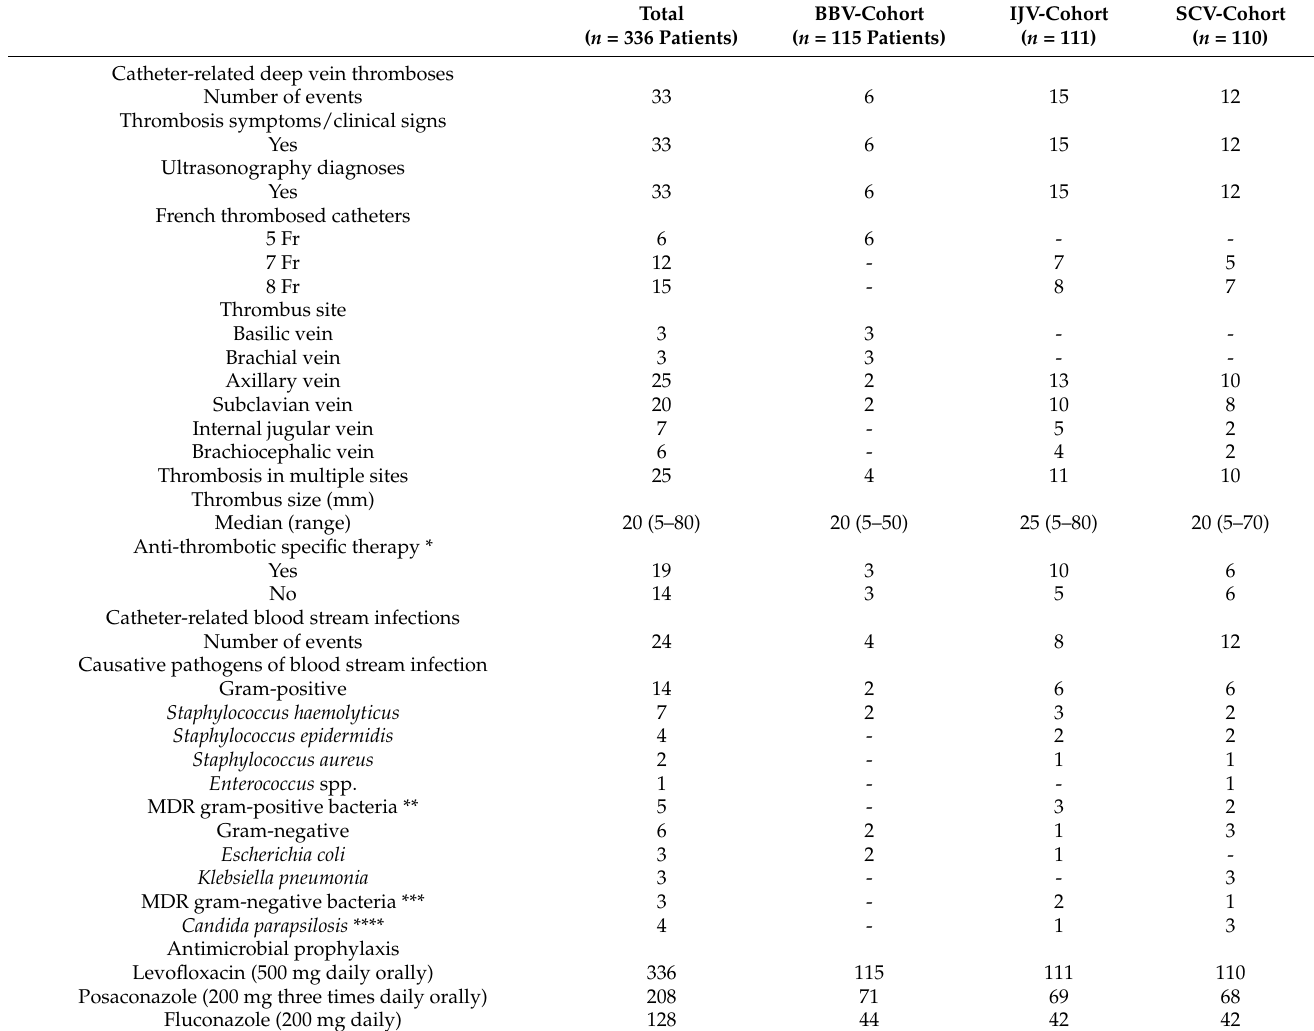
Table 4. The characteristics of catheter-related symptomatic deep vein thromboses and blood stream